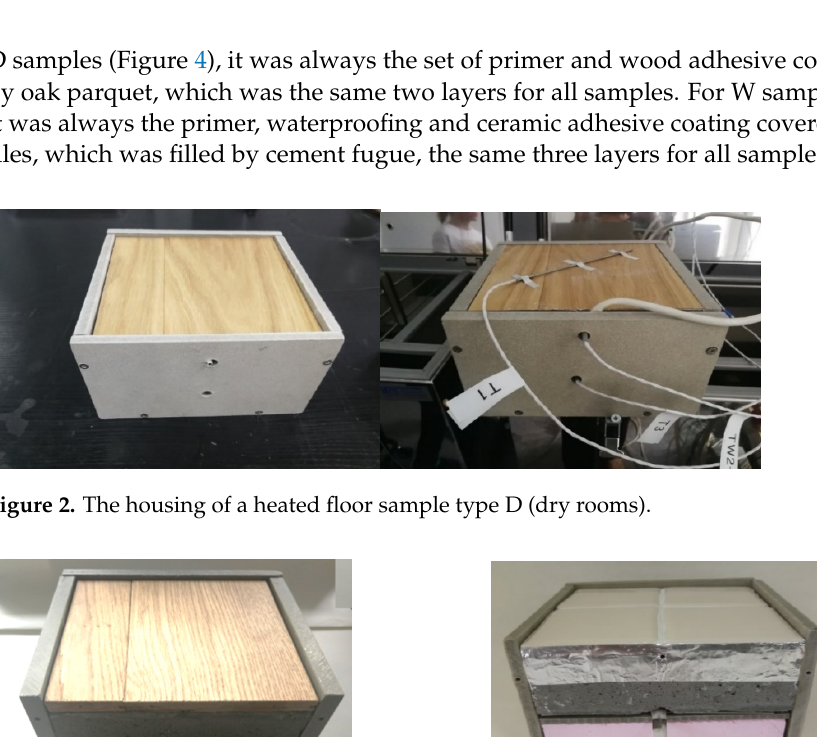
Figure 3. Cross-section of the heated floor sample ( a ) type D ( b ) type W (wet rooms).